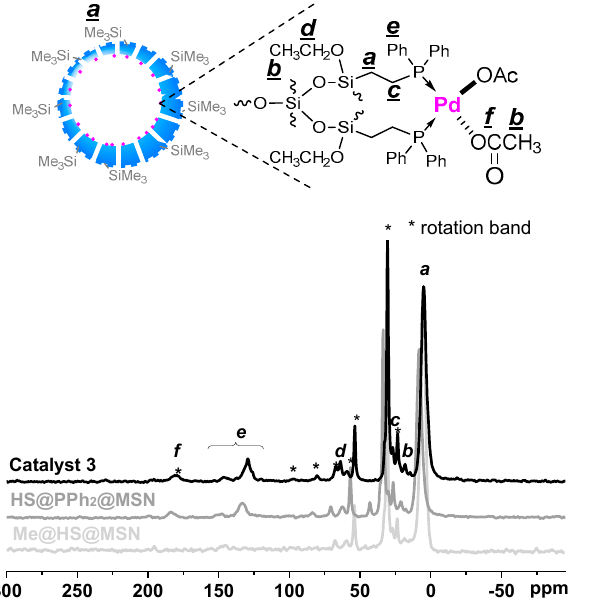
Figure 1. The solidstate 13 C CP MAS NMR spectra of one and catalyst 3 .